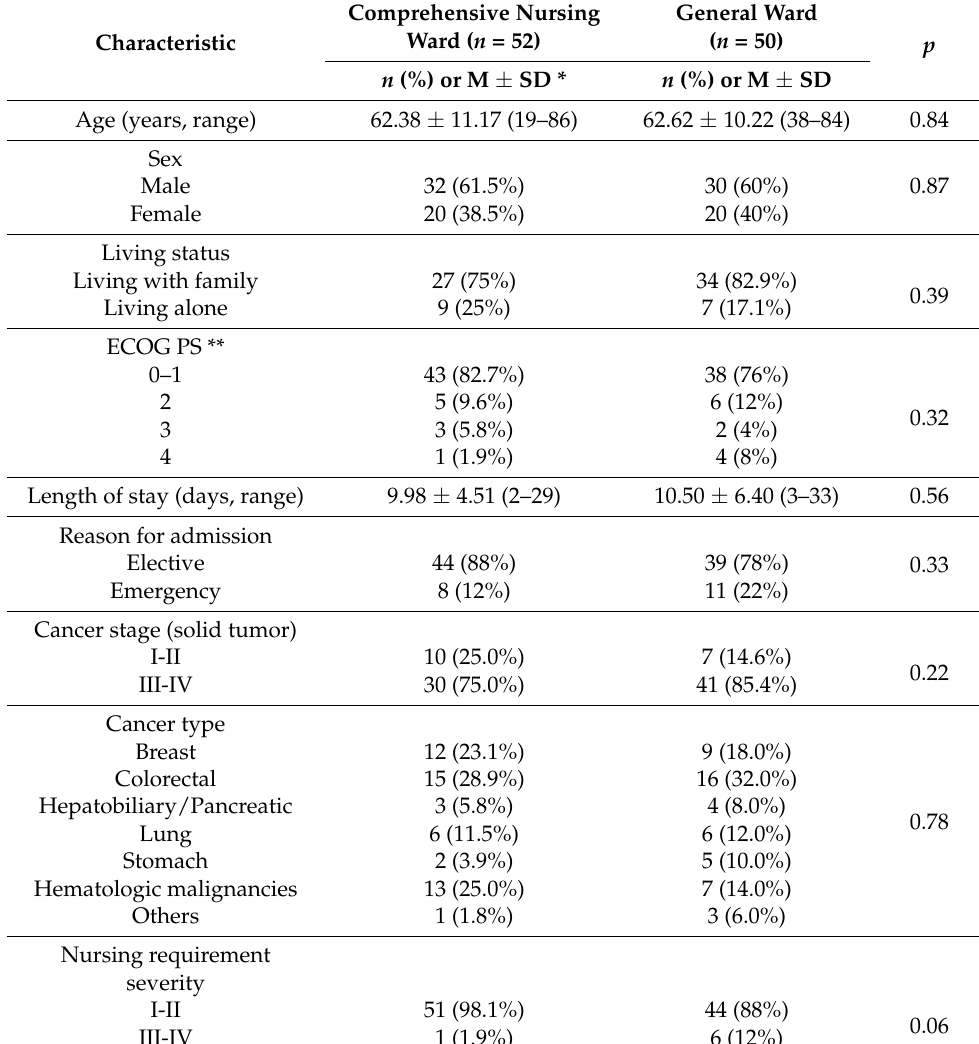
Table 2. Baseline characteristics of patients ( n =